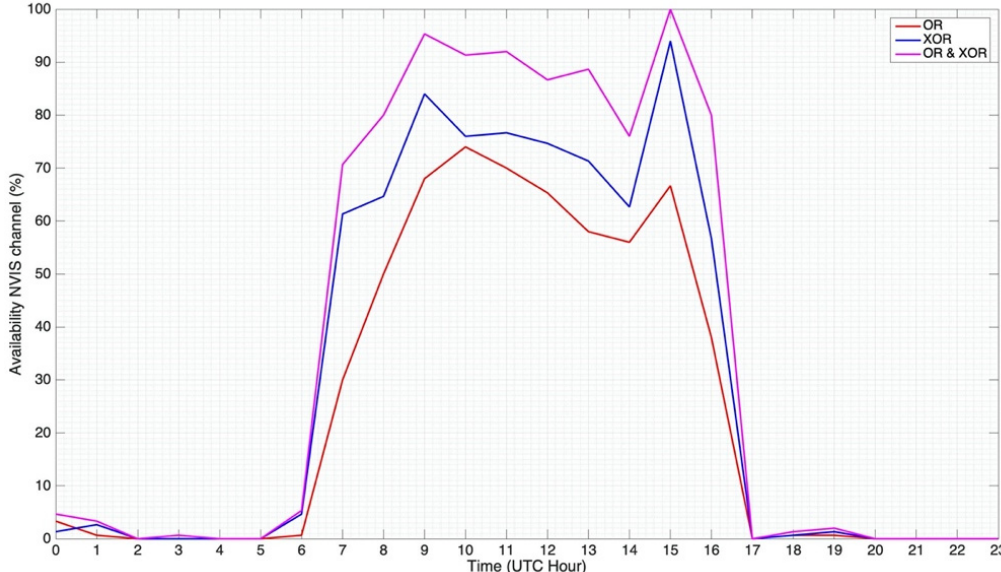
Figure 9. Availability of the Barcelona—Cambrils NVIS ionospheric channels.